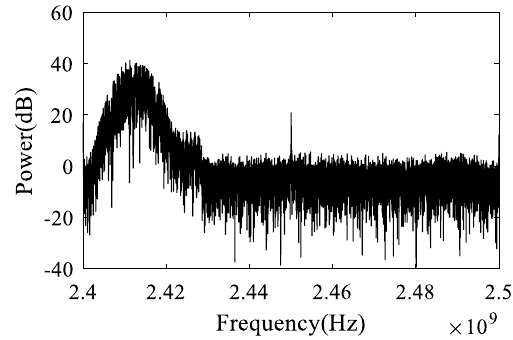
Fig. 10 Spectrum of the received